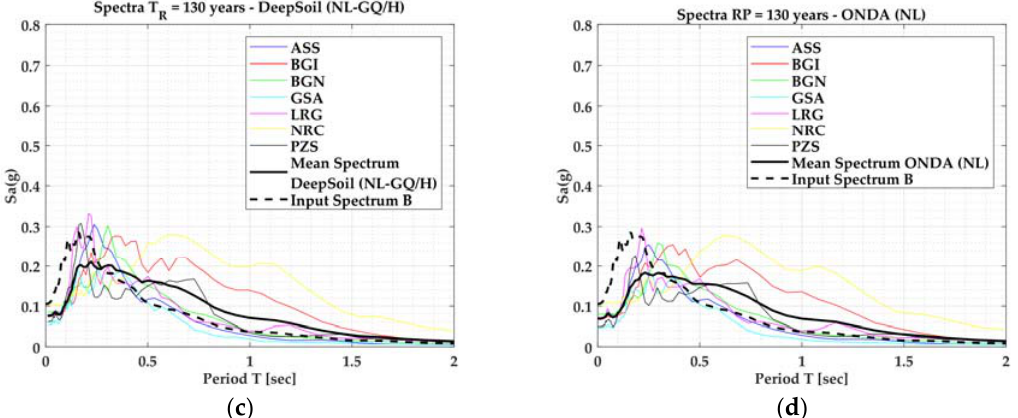
Figure 13. Results of SRA for return period = 130 years with: ( a ) STRATA (LE); ( b ) DEEPSOIL (NL-MKZ); ( c ) DEEPSOIL (NL-GQ/H); ( d ) ONDA (NL).